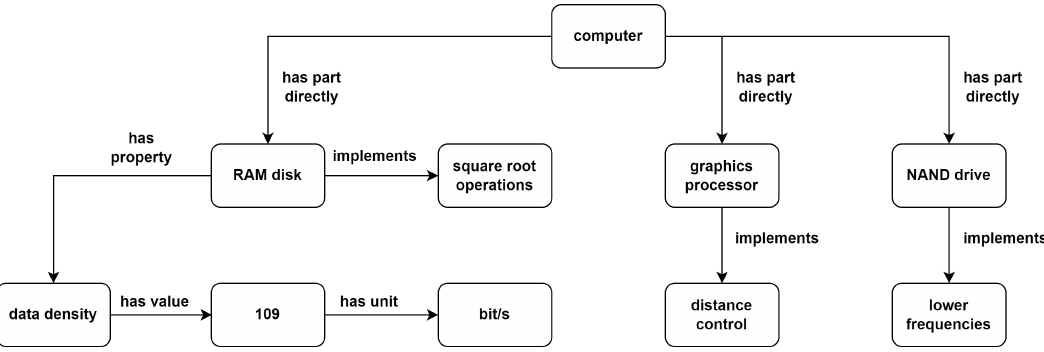
Figure 8. Knowledge graph generated with tokens from test predictions presented in Table 6.